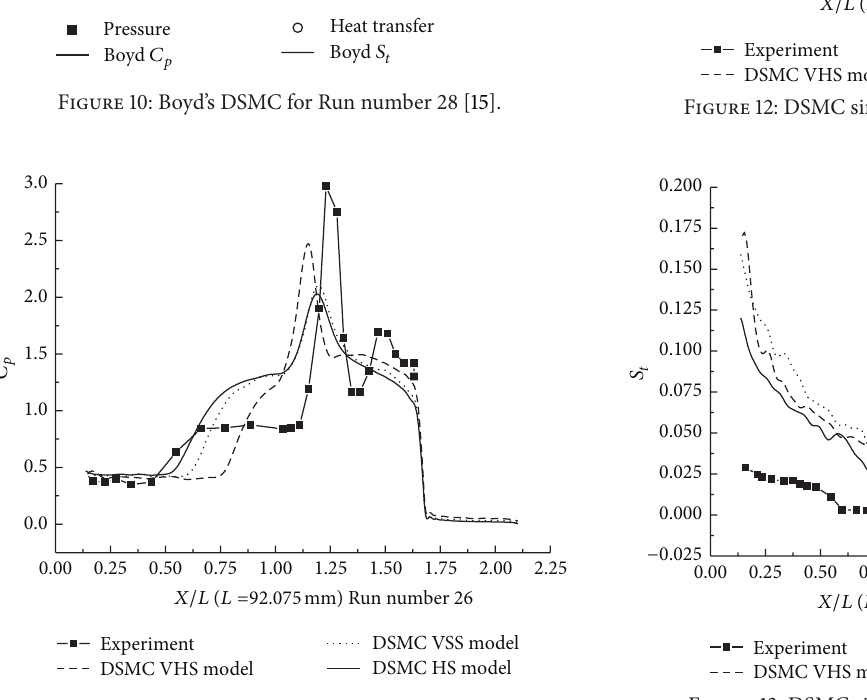
Figure 11: DSMC simulation of Run number 26 ( 𝐶 𝑃 ).